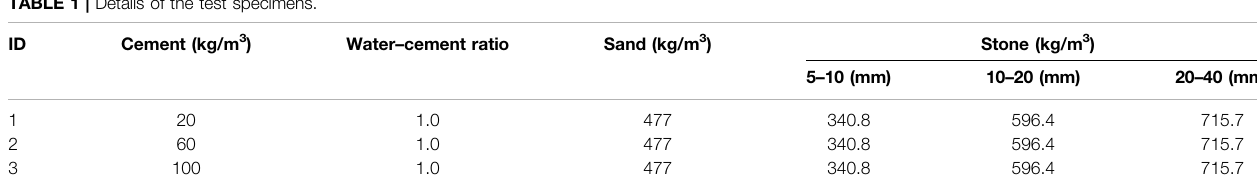
TABLE 1 | Details of the test